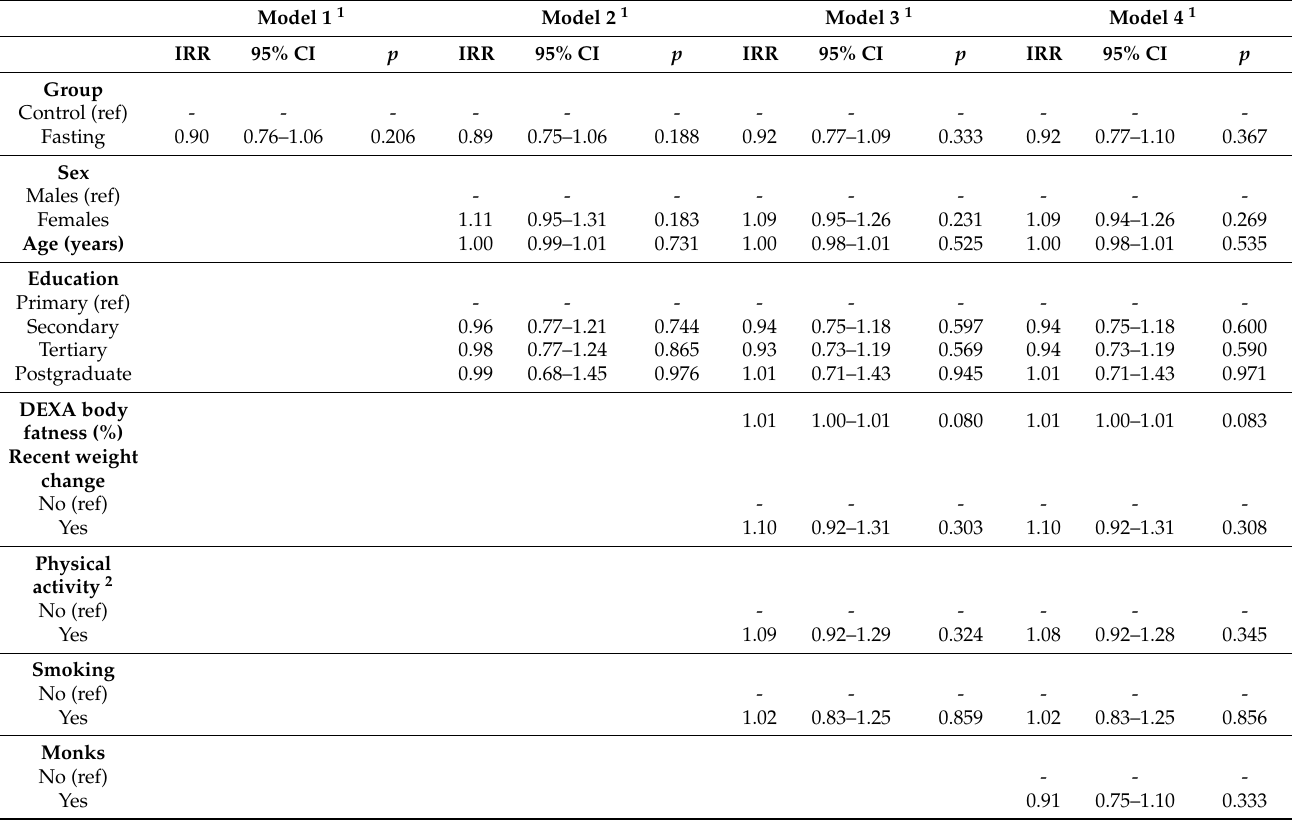
Table 5. Sensitivity analysis—negative binomial regression analysis restricted to those with a GDS score over the 75th